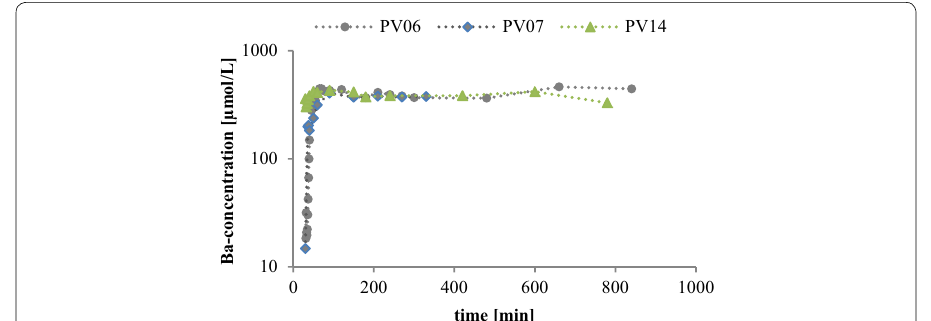
Fig. 5 PV06, PV07, and PV14 performed at 60 °C and pressures of: PV06: 350 bar, PV07: 20 bar, PV14: 300 bar